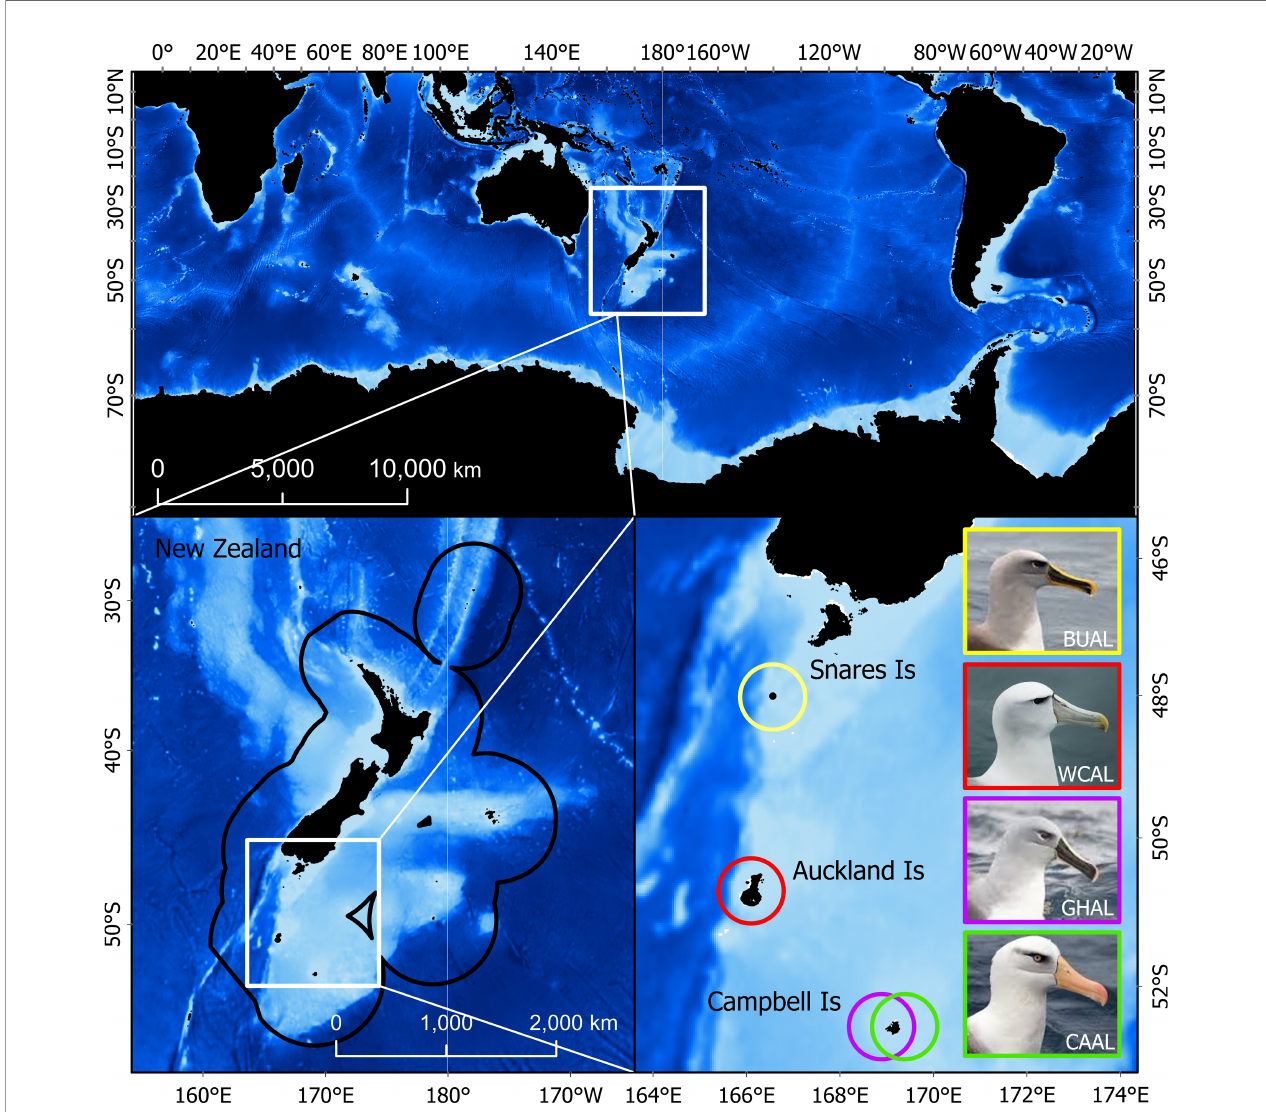
FIGURE 1 | The study region in which probability of occurrence and habitat were predicted (top). The bottom panels show the tagging locations (breeding colonies) within the New Zealand Exclusive Economic Zone for four albatross species: Buller ’ s (BUAL), white-capped (WCAL), grey-headed (GHAL), and Campbell